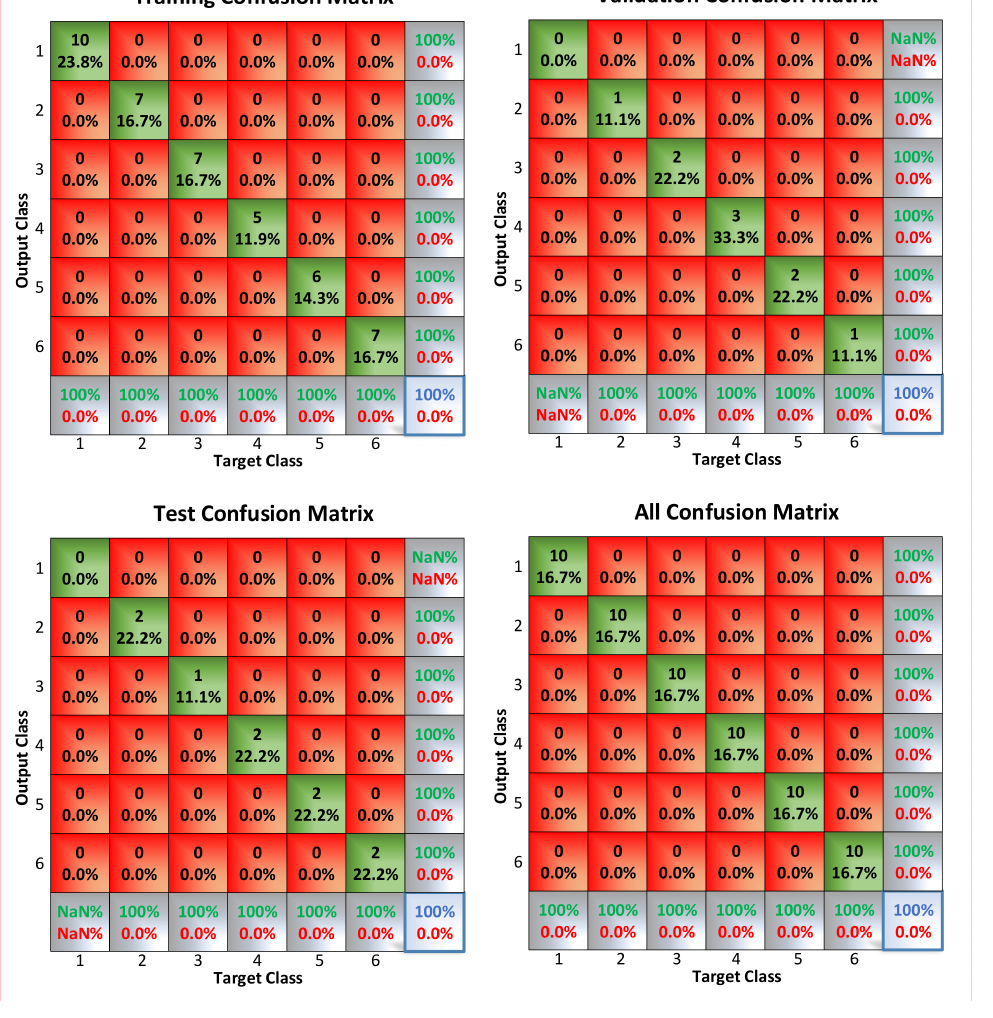
Figure 13. Training confusion matrix for the sorting of unripe